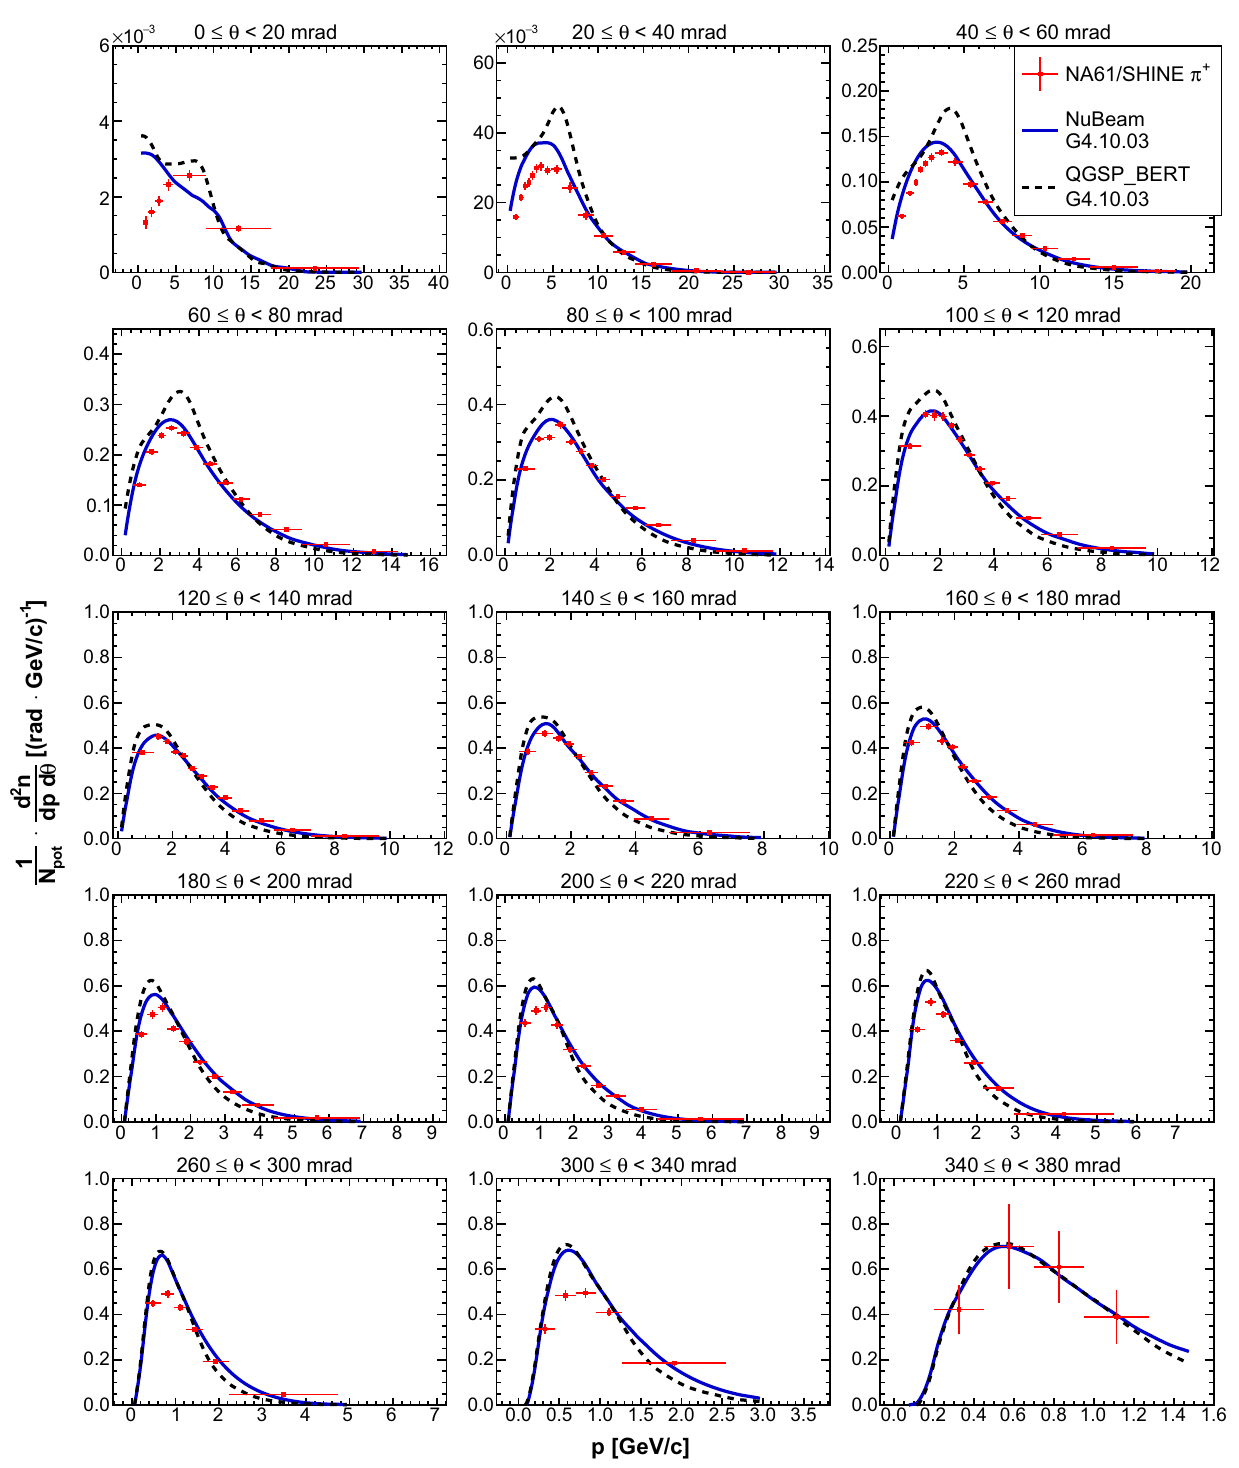
Fig. 24 Double differential yields of positively charged pions for the second upstream longitudinal bin (18 ≤ z < 36 cm). Vertical bars represent the total uncertanties. Predictions from the NuBeam (red)